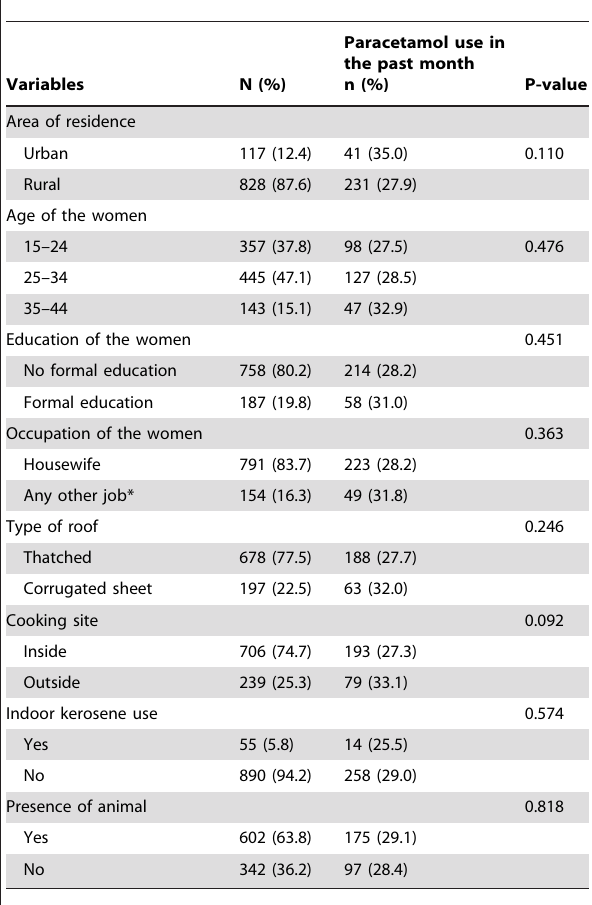
Table 1. Use of paracetamol in the past month by demographic and life style factors (N= 945).